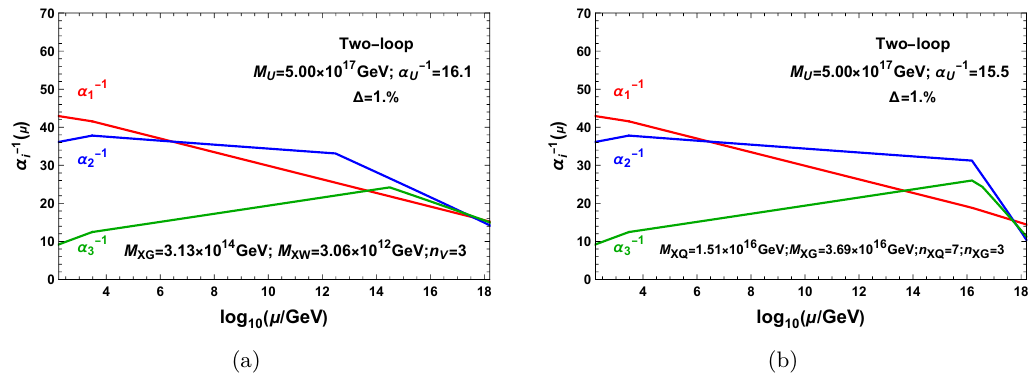
Figure 11 . Two-loop evolution of gauge couplings for the Model 6 with vector-like particles. In the model, k = 1 × 11 and k = 5 . The string-scale gauge coupling relations can be achieved by Y 2 8 6 adding 3( XG + XW ) (a) and 7( XQ + XQ ) + 3 XG (b).